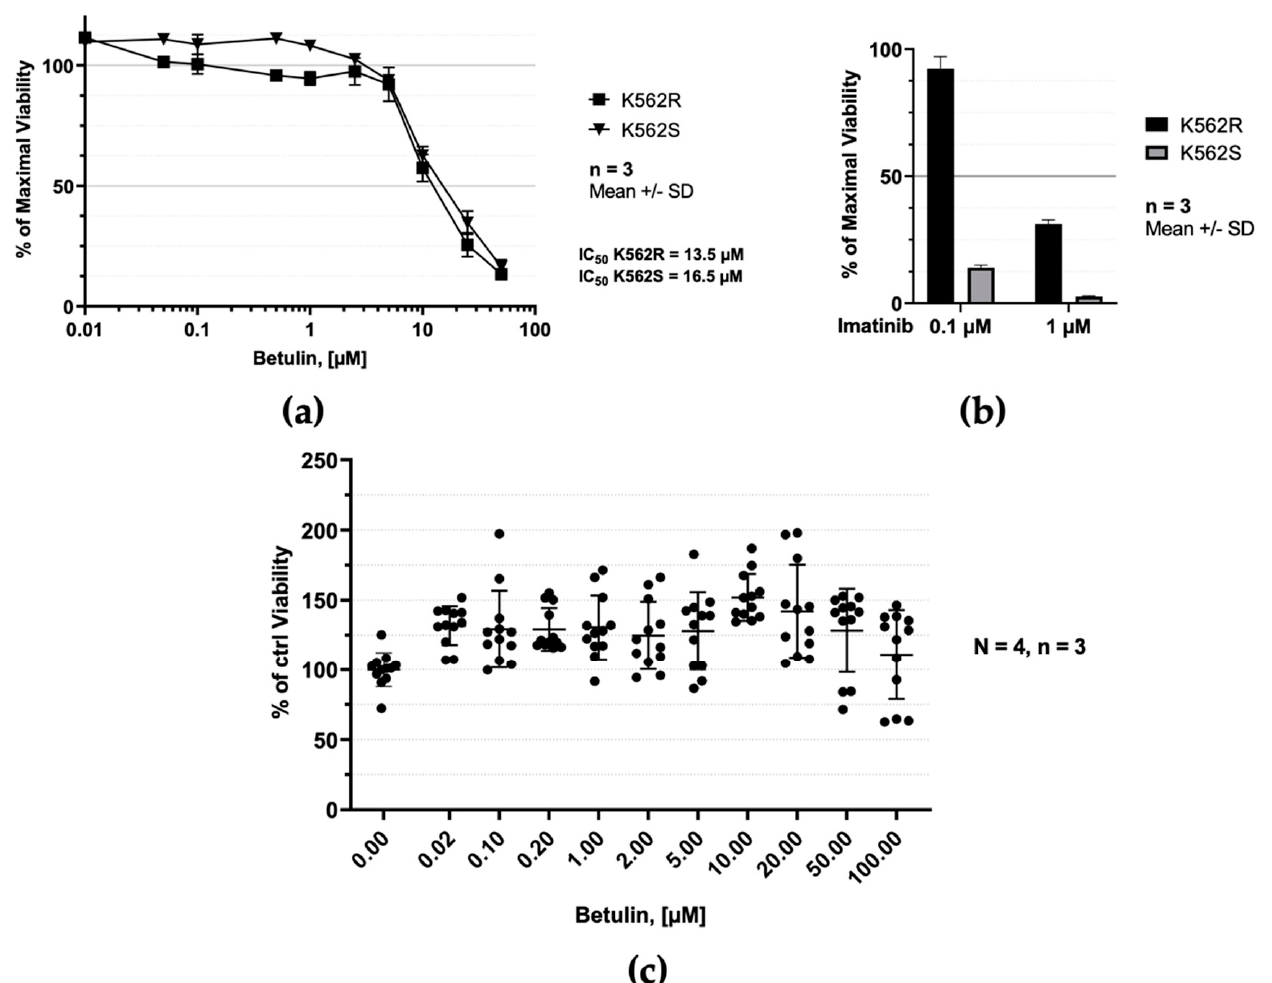
Figure 5. In vitro effects of betulin on the viability of K562 chronic myelogenous leukemia (CML) cells and human peripheral blood lymphocytes (hPBLs). ( a ) The viability of K562S and K562R CML cell lines, which are respectively sensitive (S) and resistant (R) to treatment with doxorubicin, was studied with the MTS assay. Cell viability was measured after 48 h exposure to increasing doses of betulin. The IC 50 values were determined from the dose-response curves using GraphPad PRISM Software. Data are given as mean ± SD (n = 3) expressed in % of maximal viability (normal cells treated with the identical quantity of vehicle, DMSO, only). ( b ) The viability of K562S and K562R CML cell lines was measured after 48 h exposure to 0.1 or 1 µ M of imatinib mesylate. Data are provided as mean ± SD (n = 3) expressed in % of maximal viability (relative to DMSO control, as in ( a )). ( c ) Cell viability 48 h after treatment with increasing concentrations of betulin (0.02– 100 µ M), measured with MTS assay, showing the toxicity of betulin towards human PBL. Data are expressed as mean ± SD (N = 4, n =